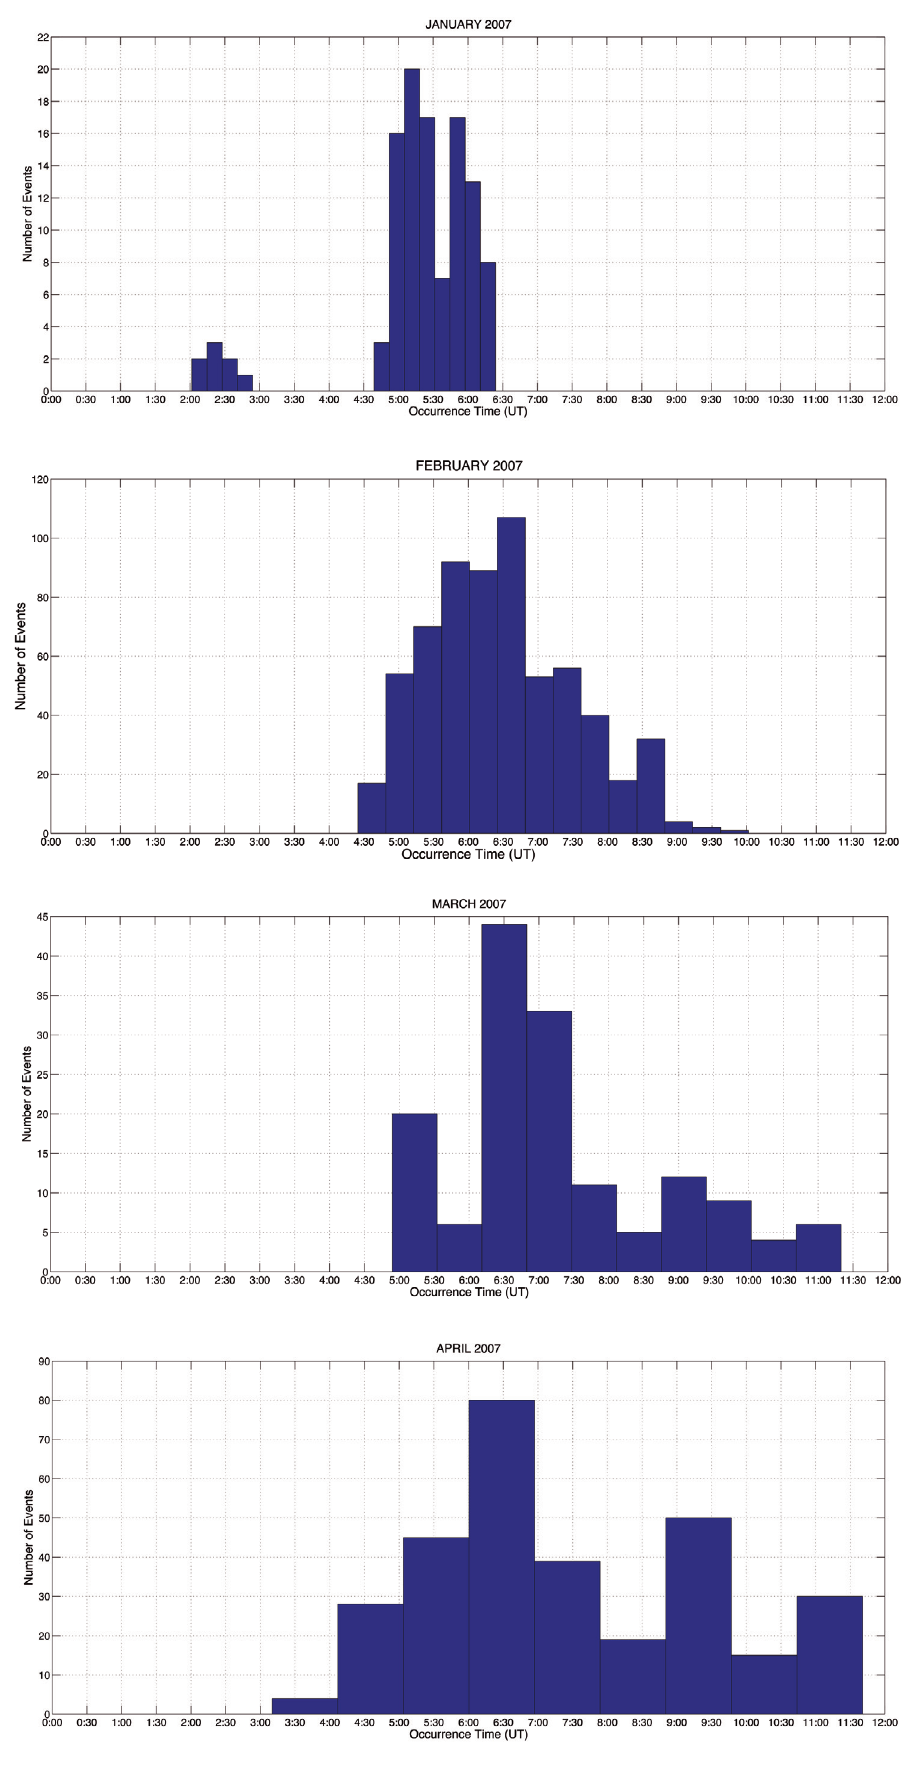
Figure 4 (continues on following page). VLF event occurrence time histograms for January to May 2007, as indicated. June is not included because of the low event